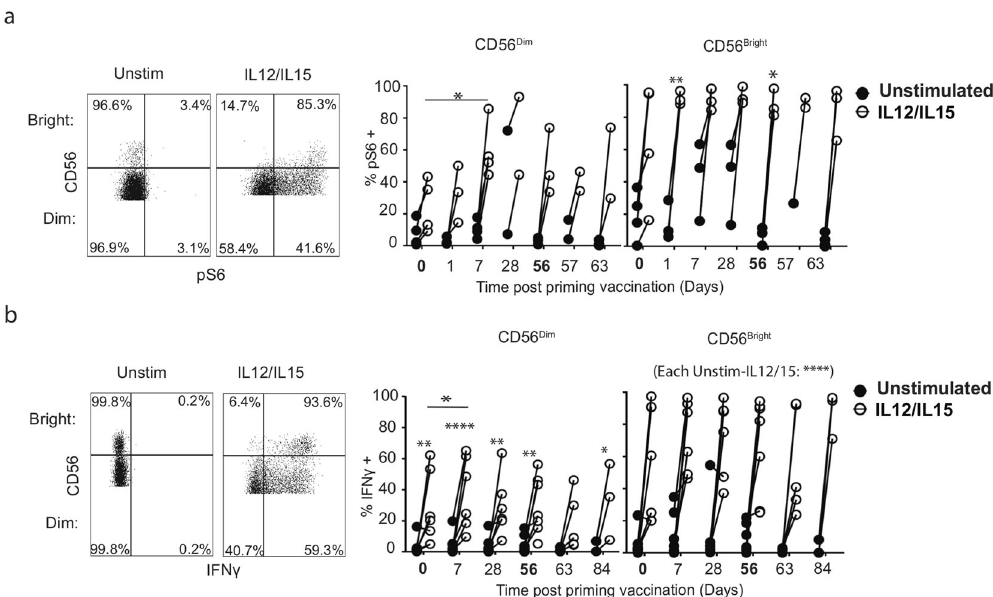
Fig. 2 Heightened mTORC1 activity and sustained IFN γ production by CD56 dim NK cells after vaccination. a Representative fl ow cytometry plots of NK cells stained with phosphorylated ribosomal protein S6 (pS6) + or b IFN γ + NK cells at baseline in unstimulated PBMC (left) or after 18 h IL-12 (30 ng) and IL-15 (100 ng) in vitro stimulation (right). Graphs show paired samples of pS6 + or IFN γ + NK cells at baseline and stimulated at indicated timepoints post vaccination in CD56 dim and CD56 bright NK cells ( n = 3 – 6). Black circles: unstimulated; white circles: IL- 12/IL-15. Bold timepoints indicate that baseline samples were taken on the day of prime (DO) or boost (D56) vaccination. a , b Samples were compared by mixed-model with Bonferroni post hoc test. n.s. not signi fi cant. * p < 0.05, ** p < 0.01 and **** p <